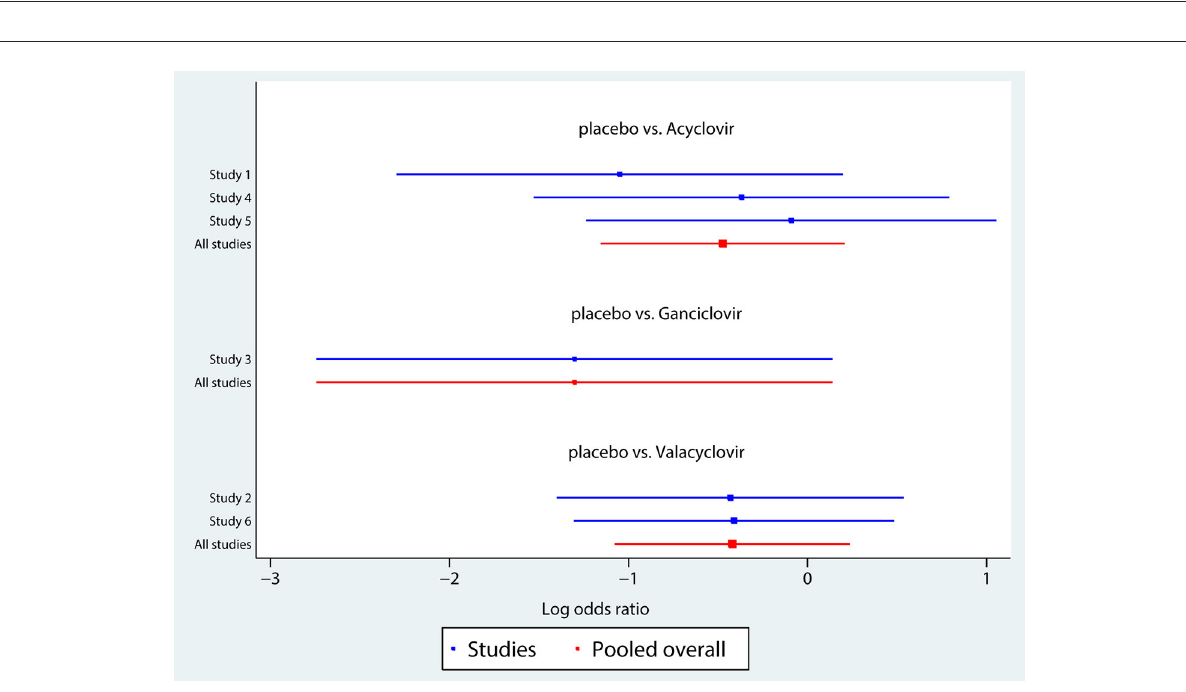
FIGURE4 Pairwise comparison agents for hearing